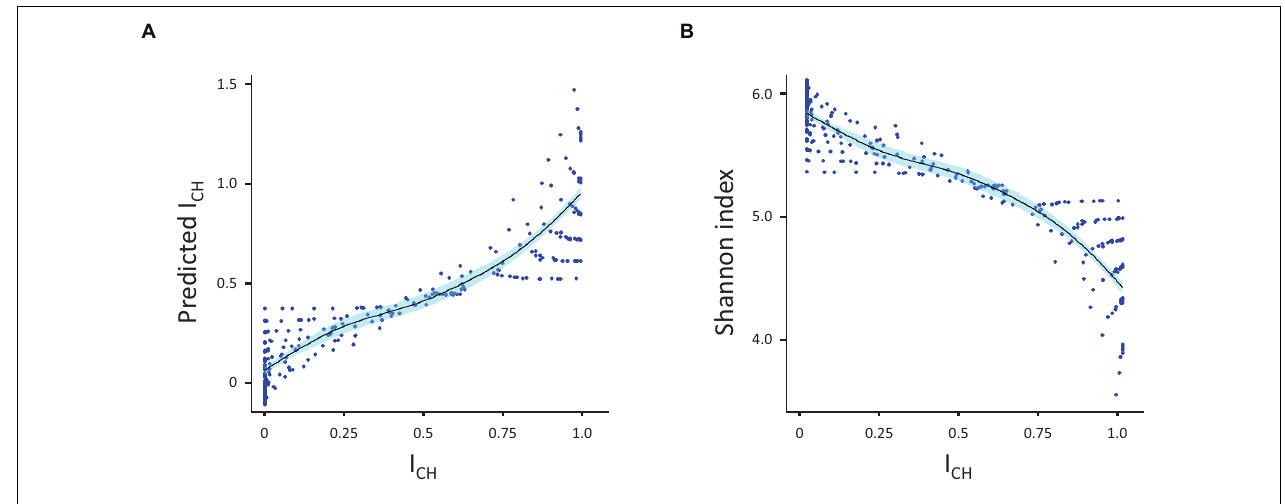
FIGURE 3 | Prediction of I CH . (A) Correlation between the measured and predicted (by linear regression) values of I CH . (B) Inverse correlation between I CH and the Shannon index. Correlations were calculated using the population diversity datasets presented in Figure 1 .